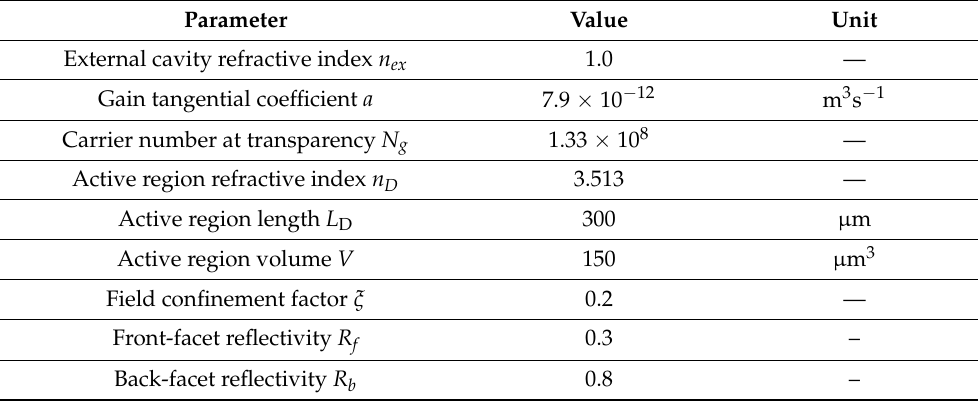
Table 1. InGaAsP/InP laser (emitting at 1550-nm) parameters which were employed in the calculations.